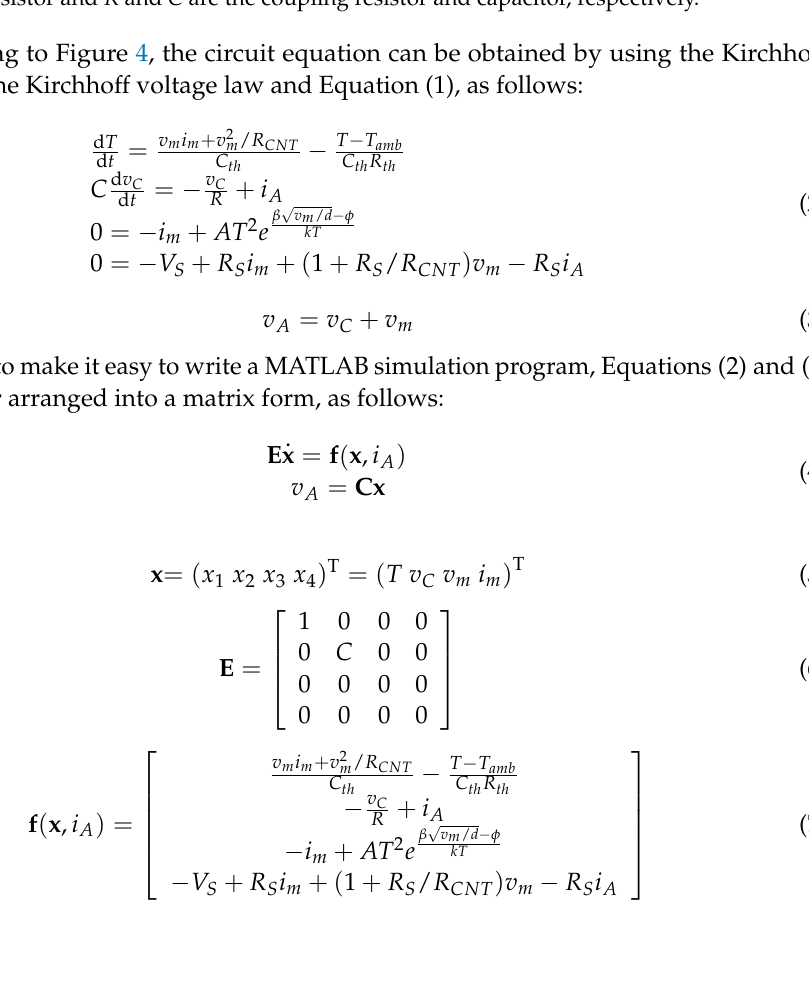
Figure 4. Cell circuit. The part shown in the dotted box is the VO 2 carbon nanotube composite